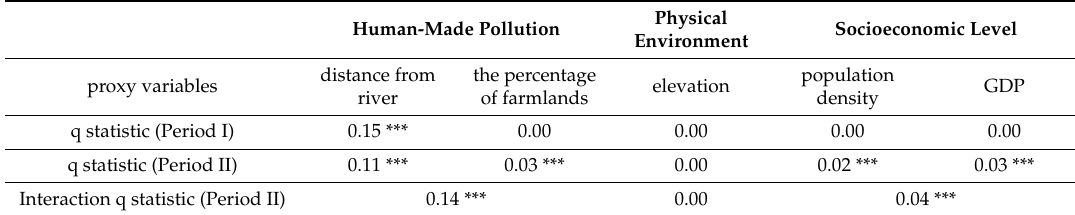
Table 2. Determinants of GCM spatial